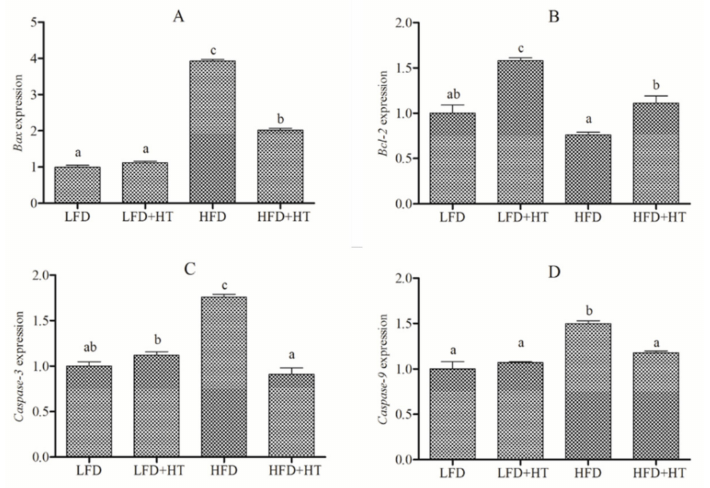
Figure 4. Relative expression of apoptosis-related genes ( A ) Bax ( B ) Bcl-2 ( C ) Caspase-3 ( D ) Caspase-9 in the liver of blunt snout bream fed with experimental diets. Bars with different letters are significantly different ( p <